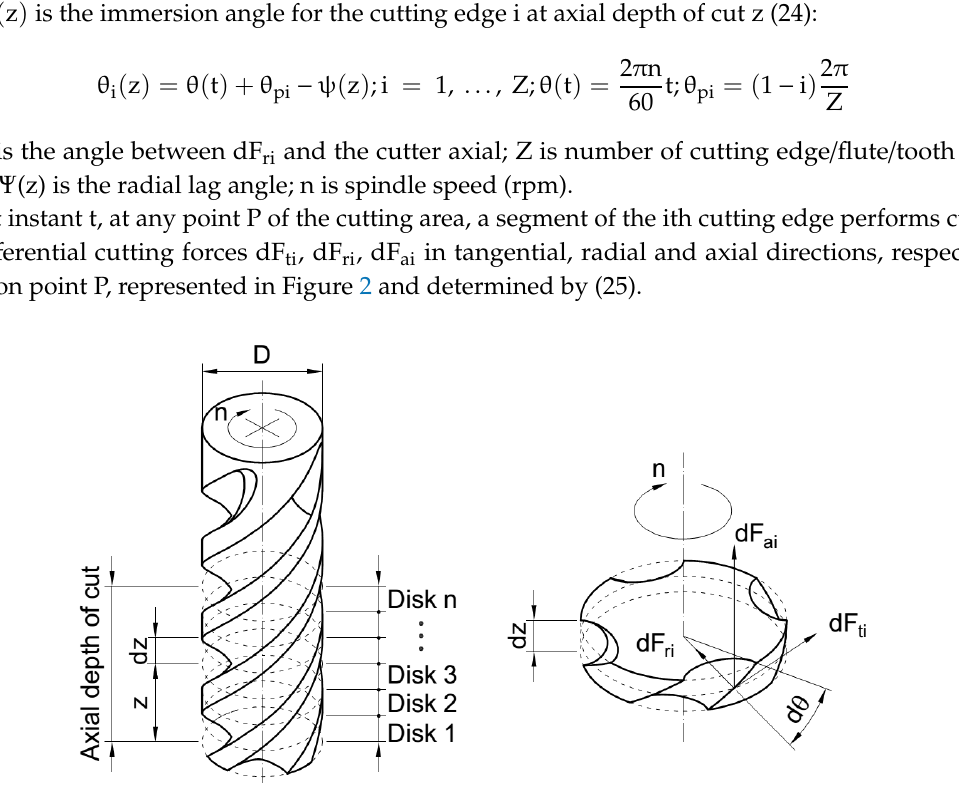
Figure 2. Representation of the cutting force model of the cutting edge i of a disk dz in milling.